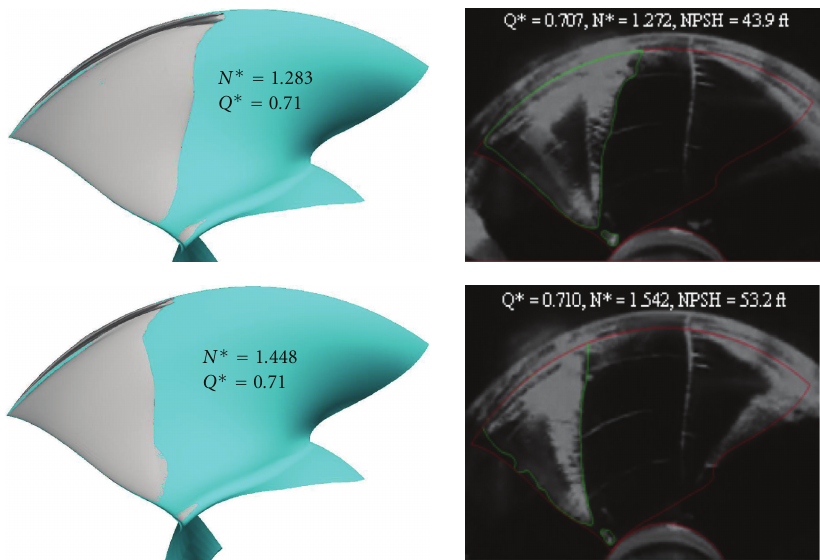
Figure 6: Waterjet pump, AXWJ-2, rotor suction-surface cavitation patterns. Photographs from testing [20] and results from RANS-based modeling. Cavitation is illustrated with α v = 0 . 5 isosurface.